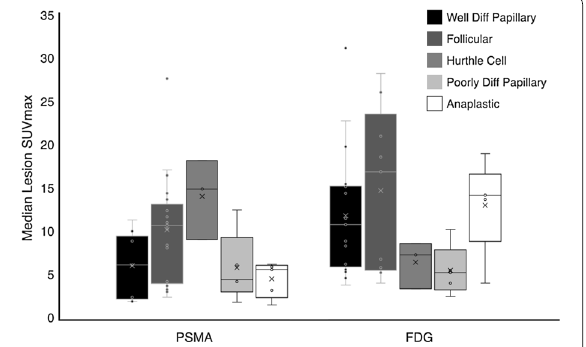
Fig. 2 Box and whisker plot of Median SUVmax for all lesions by thyroid cancer subtype. Diff = patients, PSMA uptake was higher than FDG uptake. For example, Patient 6 with PDPTC had a higher median SUVmax in mediastinal and bilateral hilar metastases on PSMA PET (8.5) than on FDG (4.1) (Fig. 3a, b). However,